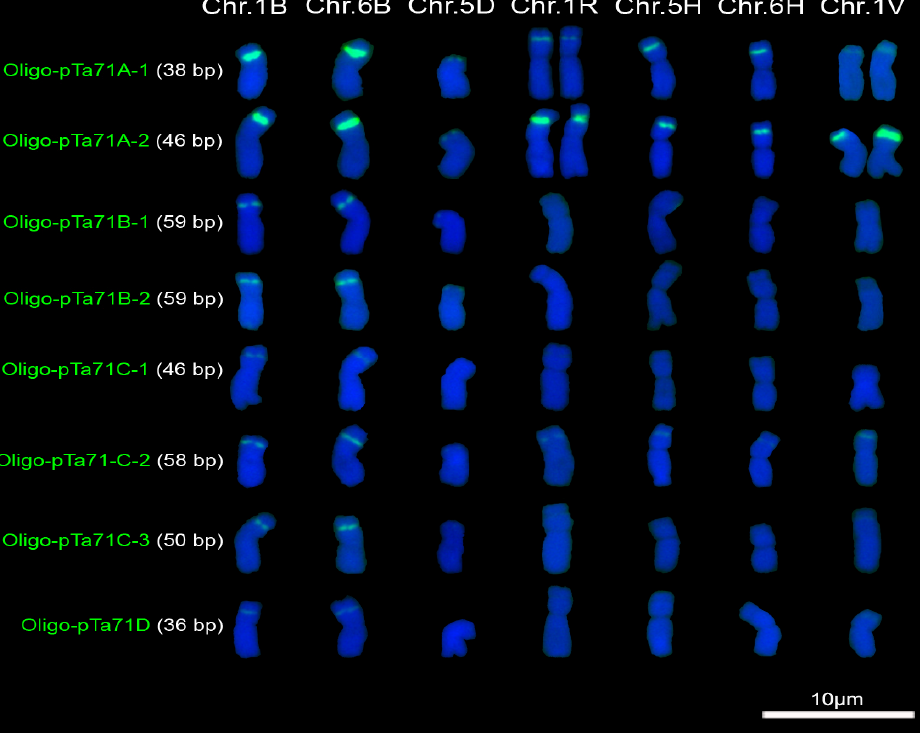
Figure 4. Signal patterns of the eight oligonucleotide probes ( green ) derived from pTa71 on the root tip metaphase chromosomes of common wheat Chinese Spring, rye PI 428373, barley cultivar CNSimai 1 and D. villosum W6 21717. Chr.: chromosome. Chromosomes were counterstained with 4 ′ ,6-diamidino-2-phenylindole (DAPI) ( blue ). Scale bar: 10 μ m. Oligo-pTa71B-1, Oligo-pTa71B-2, Oligo-pTa71C-2 and Oligo-pTa71C-3 generated obvious S4).Oligo-pTa71C-1 and Oligo-pTa71D produced weak signals on 1B and 6B chromosomes (Figure 4;